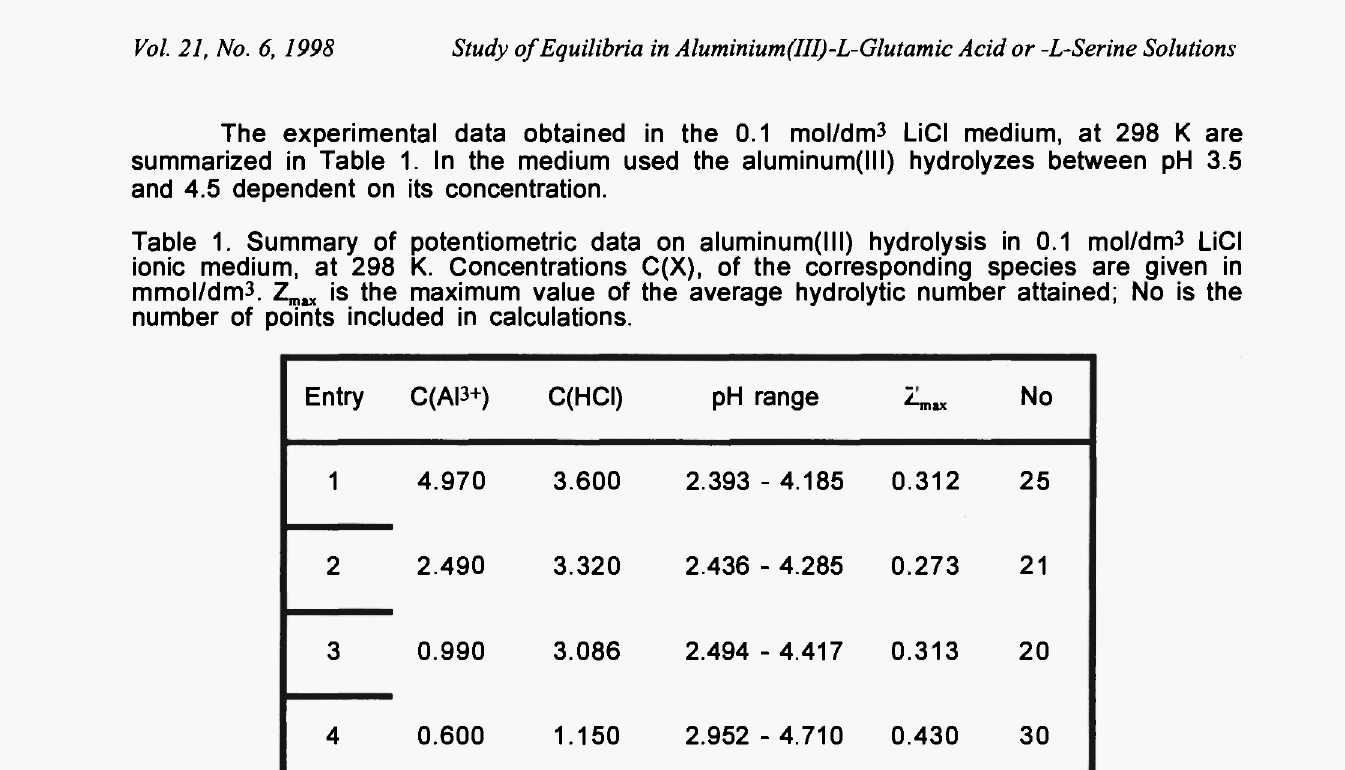
Table 1. Summary of Potentiometrie data on aluminum(lll) hydrolysis in 0.1 mol/dm3 LiCI ionic medium, at 298 K. Concentrations C(X), of the corresponding species are given in mmol/dm3. Z max is the maximum value of the average hydrolytic number attained; No is the number of points included in